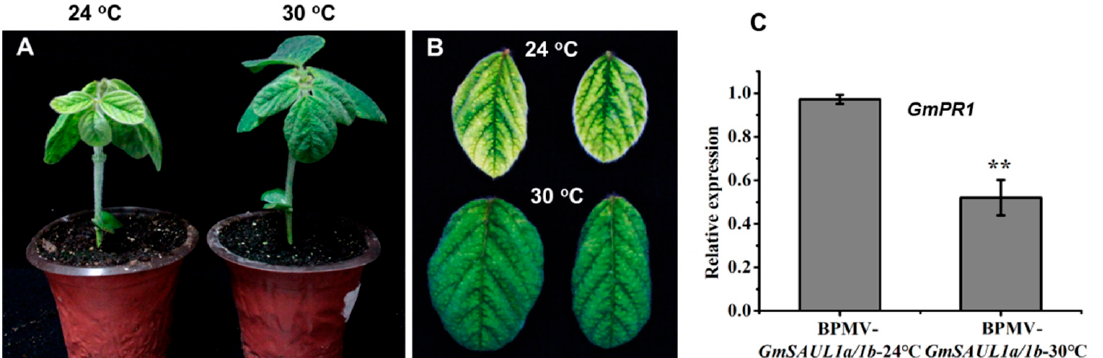
Figure 4. High temperature (30 °C) could partially suppress the auto-immune phenotype of the GmSAUL1a/1b -silenced plants. Comparison of the whole plant phenotype ( A ) and the leaf phenotype ( B ) of the GmSAU1a/1b -silenced plants grown at 24 ◦ C and 30 ◦ C. ( C ) GmPR1 gene expression of the GmSAUL1a/1b -silenced plants is significantly reduced at 30 ◦ C relative to at 24 ◦ C. ** indicate significant level at 0.01%.